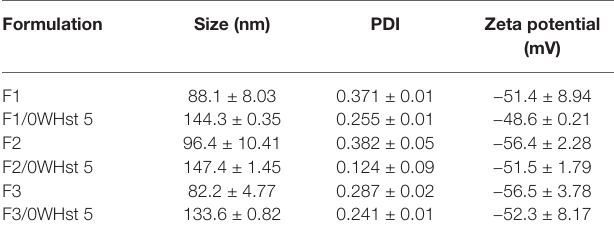
TABLE 4 | Size, PDI, and zeta potential for empty and loaded F1, F2, and F3 liposomes, obtained by sonication. Formulation